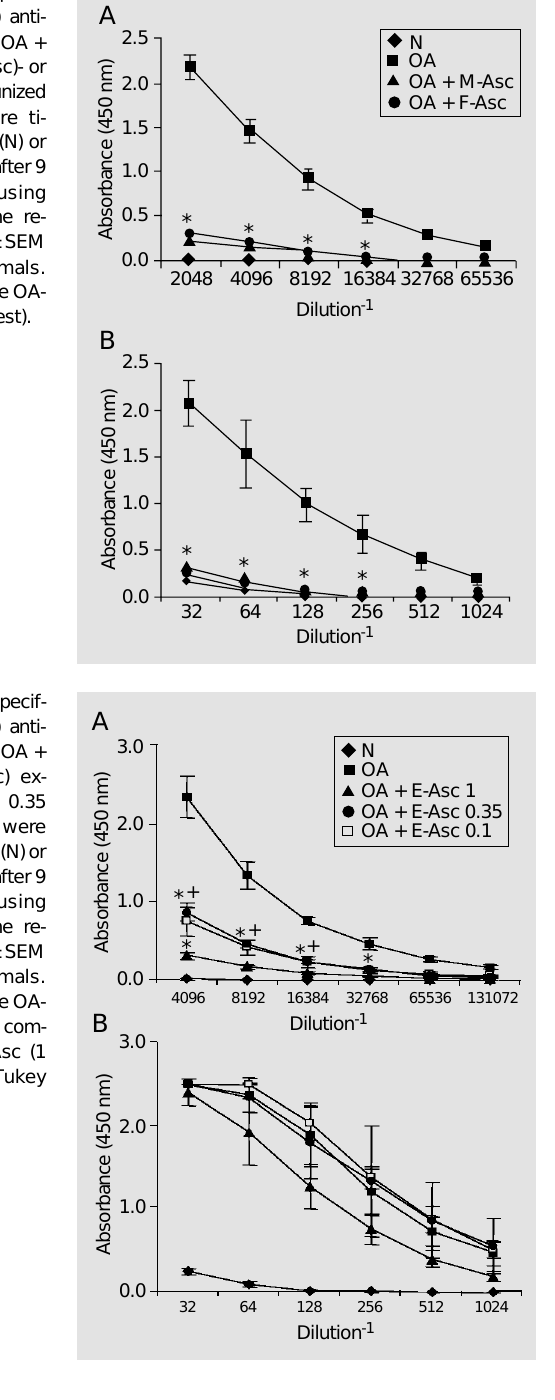
Figure 2. Ovalbumin (OA)-specif- ic IgG1 (A) and IgG2a (B) anti- bodies produced by OA or OA + Ascaris suum female (F-Asc)- or male (M-Asc) extract-immunized mice. Isotype levels were ti- trated by ELISA in normal (N) or immune plasma obtained after 9 days of immunization using monospecific antisera. The re- sults represent the mean ± SEM absorbance for 5-7 animals. *P<0.01 compared with the OA- immunized group (Tukey test).